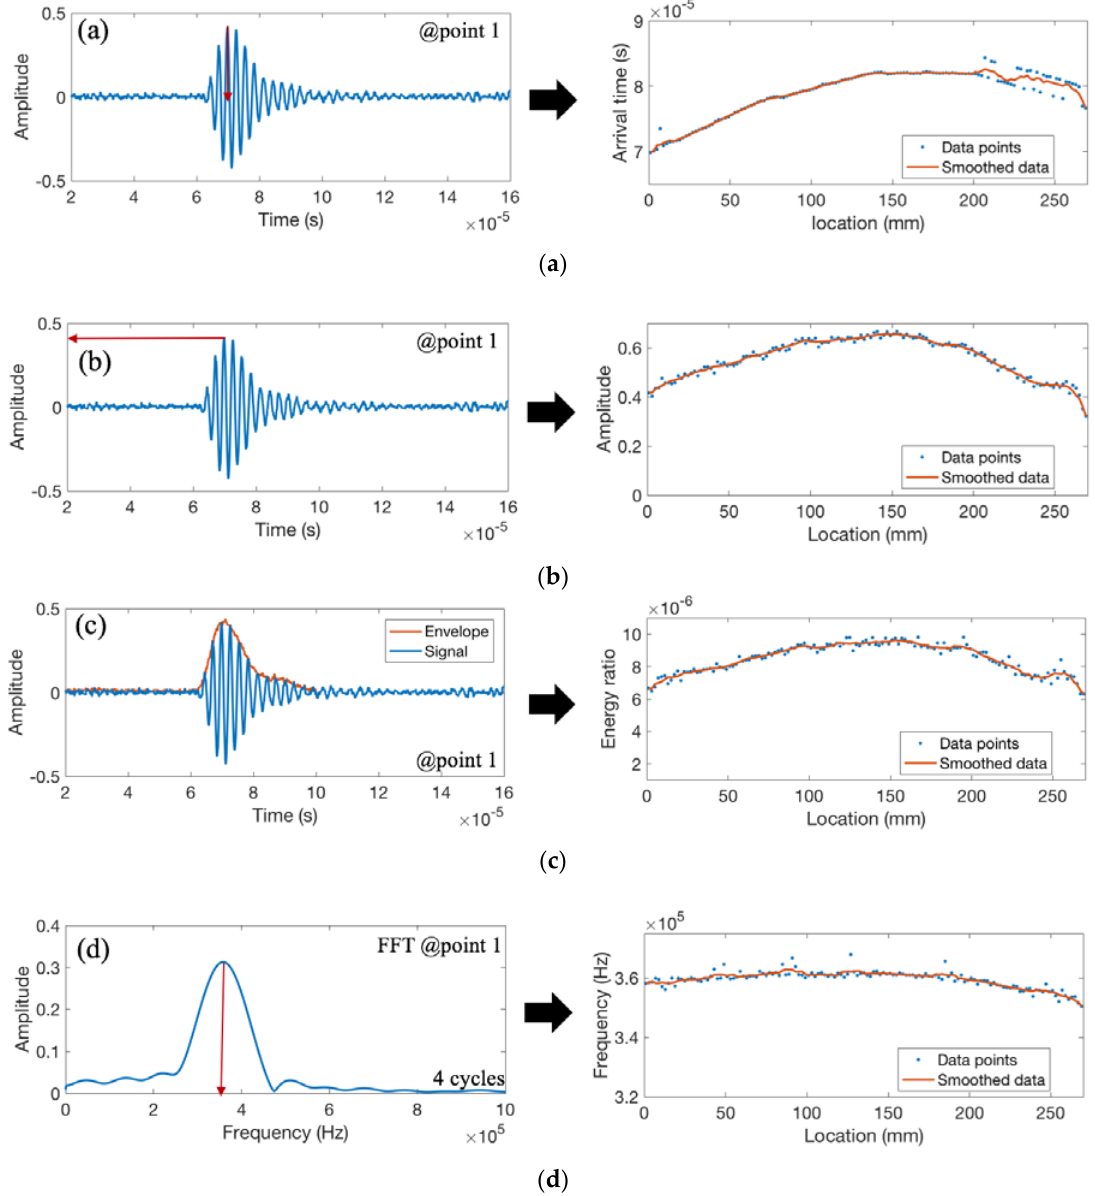
Figure 10. The recorded waveform and features extracted from weld coupon No. 1 corresponding to ( a ) the arrival time of the peak amplitude; ( b ) the peak amplitude; ( c ) the area under the envelope of the first arrived waveform; and ( d ) the peak